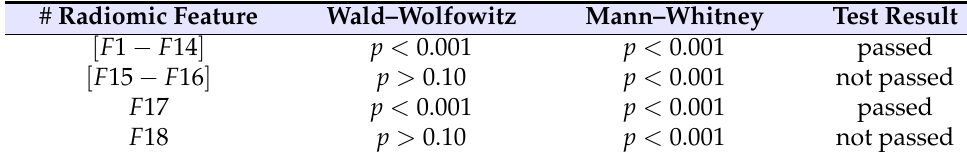
Table 2. Wald–Wolfowitz and Mann–Whitney null hypothesis H 0 test